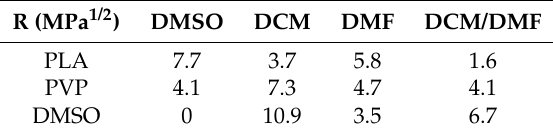
Table 3. Interaction parameters R between polymer and